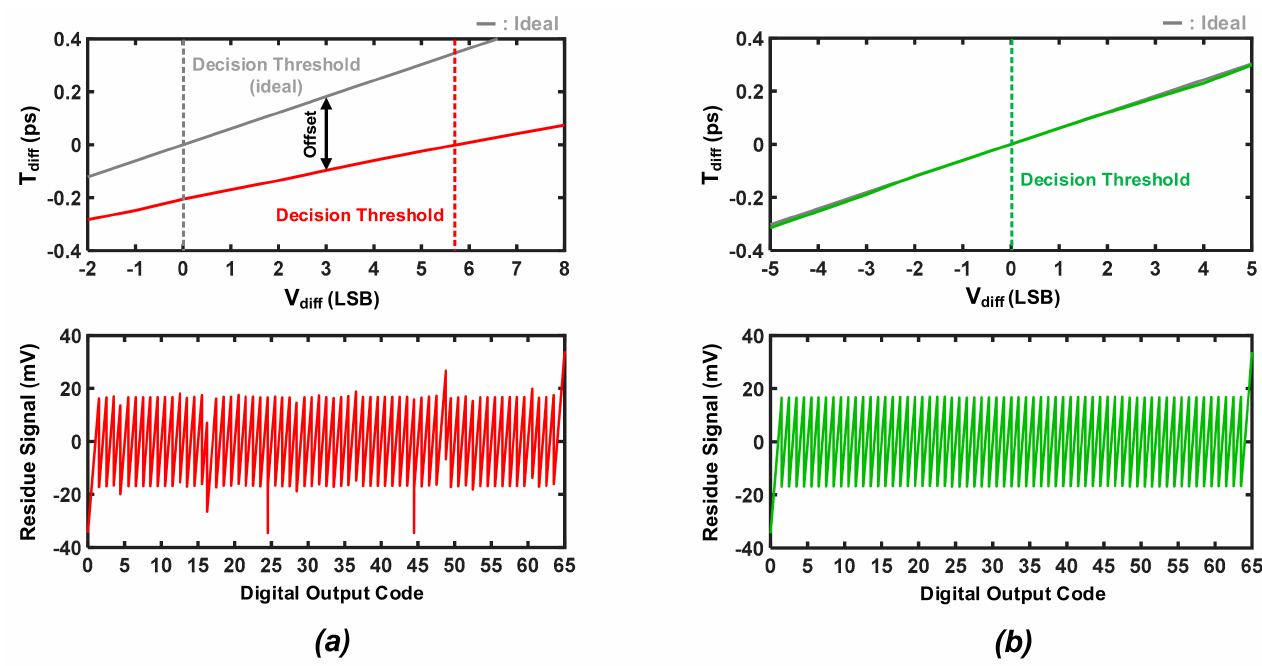
Figure 10. Simulated time comparator offset and residue signal after coarse conversion: ( a ) conventional; ( b )